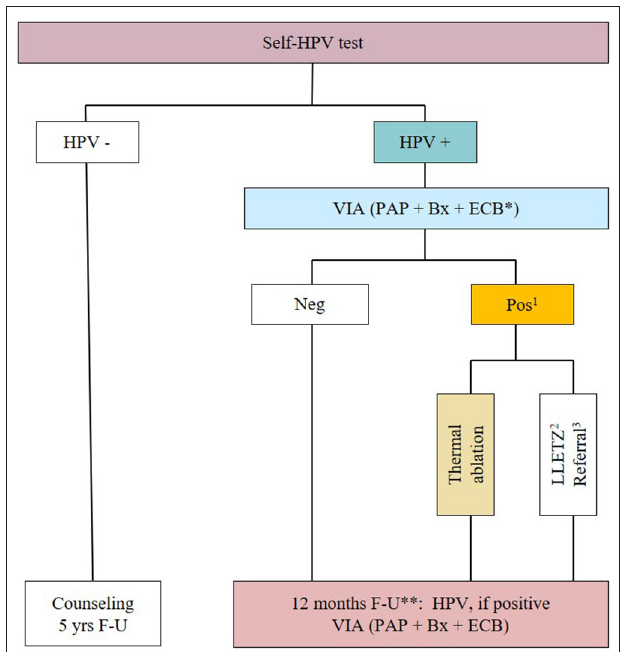
FIGURE 1 | Flowchart of the study. *HPV-positive women will undergo Papanicolaou smear (PAP), cervical biopsy (Bx) and endocervical brushing (ECB); (1) Inspection for eligibility for thermal ablation; (2) If not eligible for thermal ablation; (3) If suspicious for cancer. HPV, Human papillomavirus; Self-HPV, HPV self-sampling; LLETZ, Large loop excision of the transformation zone; VIA, Visual inspection with acetic acid and Lugol’s iodine; F-U: follow-up. **Women treated by thermal ablation also had a post-operative consultation at 4 to 6 weeks, and a follow-up at 6 months with Self-HPV, if positive VIA, PAP, Bx, and ECB.